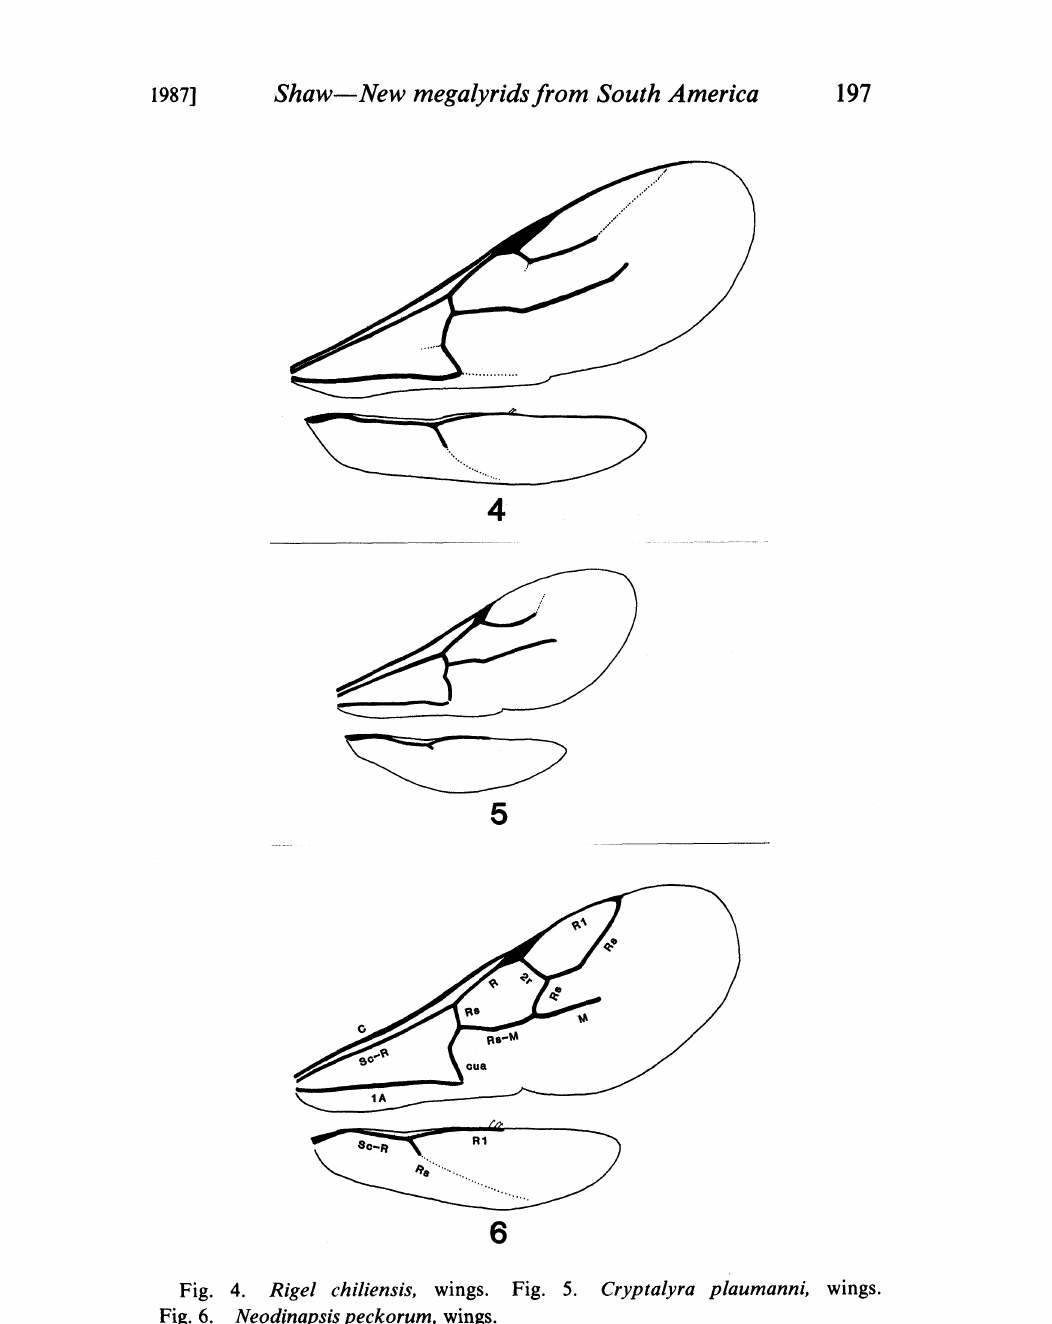
Fig. 4. Rigel chiliensis, wings. Fig. 5. Cryptalyra plaumanni, wings. Fig. 6. Neodinapsispeckorum,